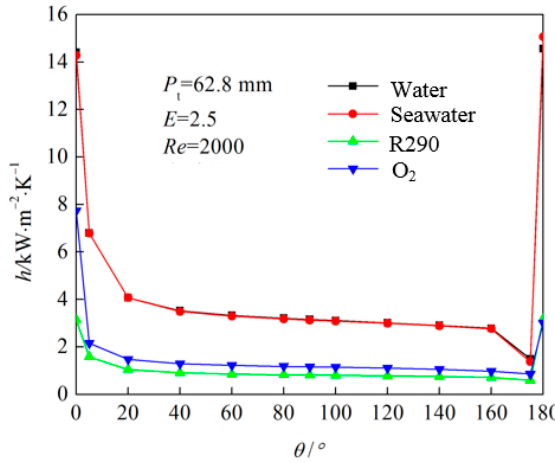
Figure 17. Local heat transfer coefficient h on the elliptical tube.